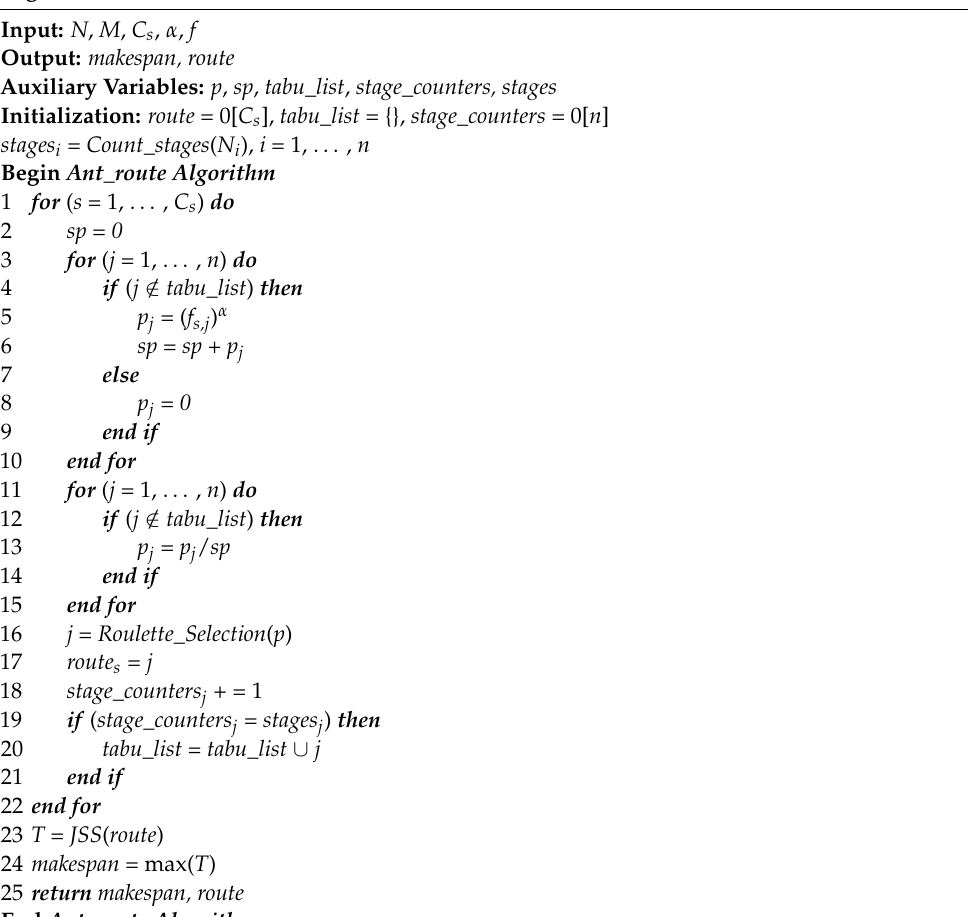
Algorithm 2. Pseudo Code for the